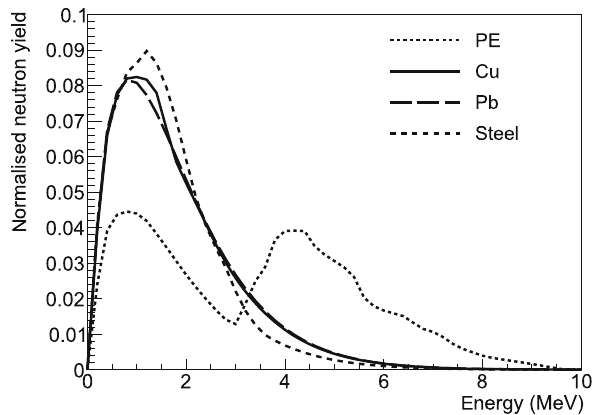
Fig. 6 Energy spectrum of radiogenic neutrons obtained using the SOURCES4C code [25] for PE, Pb and Cu shielding layers. The dou- ble peak in the energy distribution of PE is due to the presence of 13 C, which has a high cross section for (α, n ) interactions. All spectra are normalized to unit integral